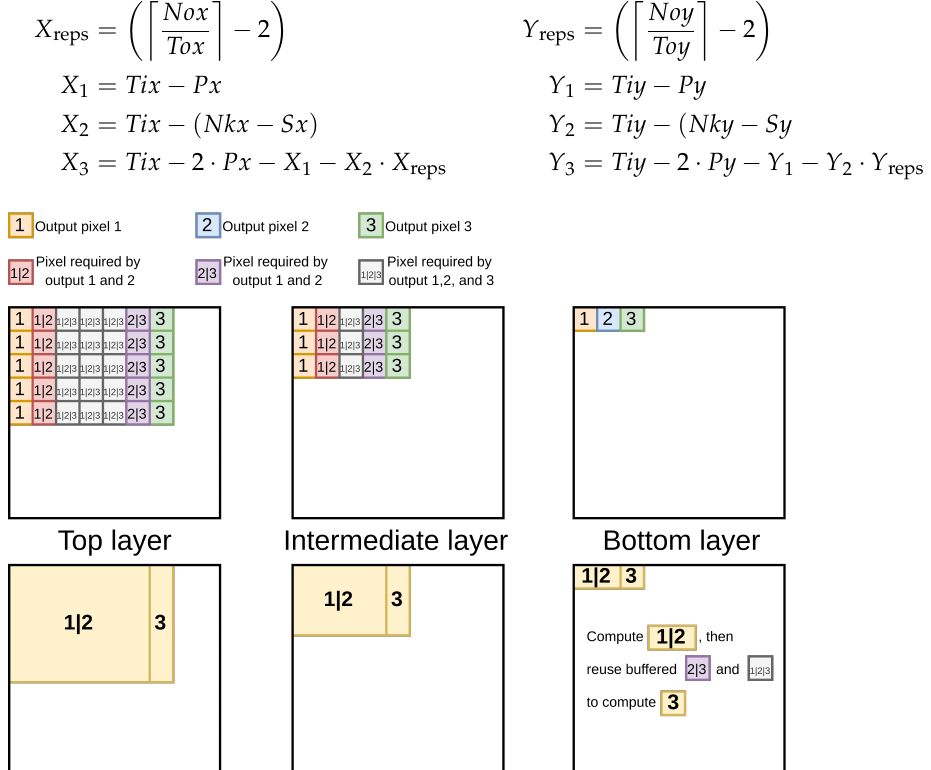
Figure 8. Example of multi-tiling applied to generate two output tiles of two and one output pixels.